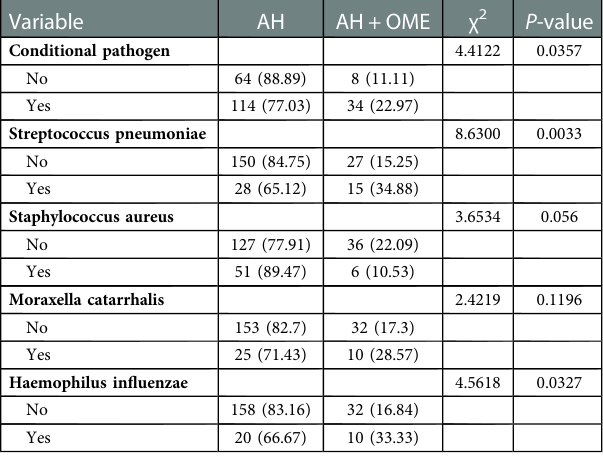
TABLE 3 Relationship between conditional pathogen culture and patients with adenoid hypertrophy with otitis media with